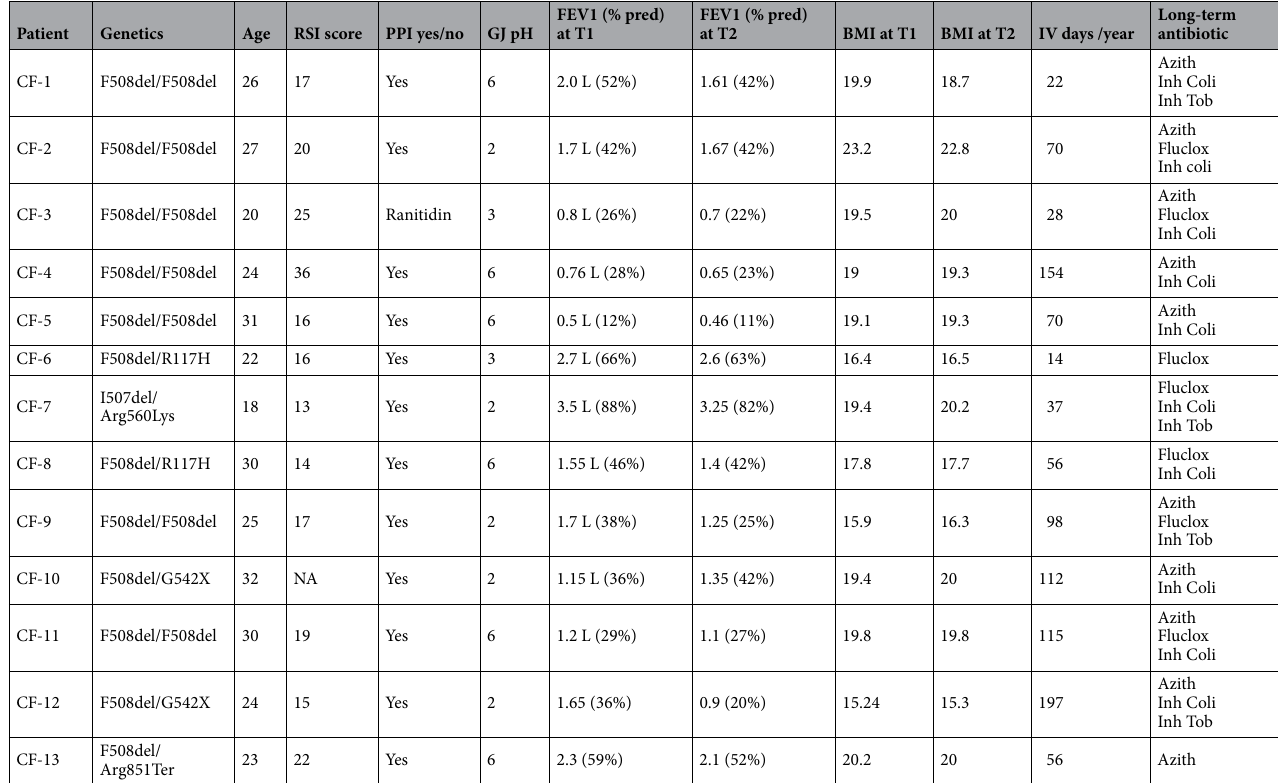
Table 1. Demographic and clinical data for CF patients at T1 and at T2. FEV1 forced expiratory volume in 1 s, Azith oral azithromycin long-term, Fluclox oral flucloxacillin long-term, Inh Coli inhaled colistin (nebulised or inhaler), Inh Tob inhaled tobramycin (nebulised or